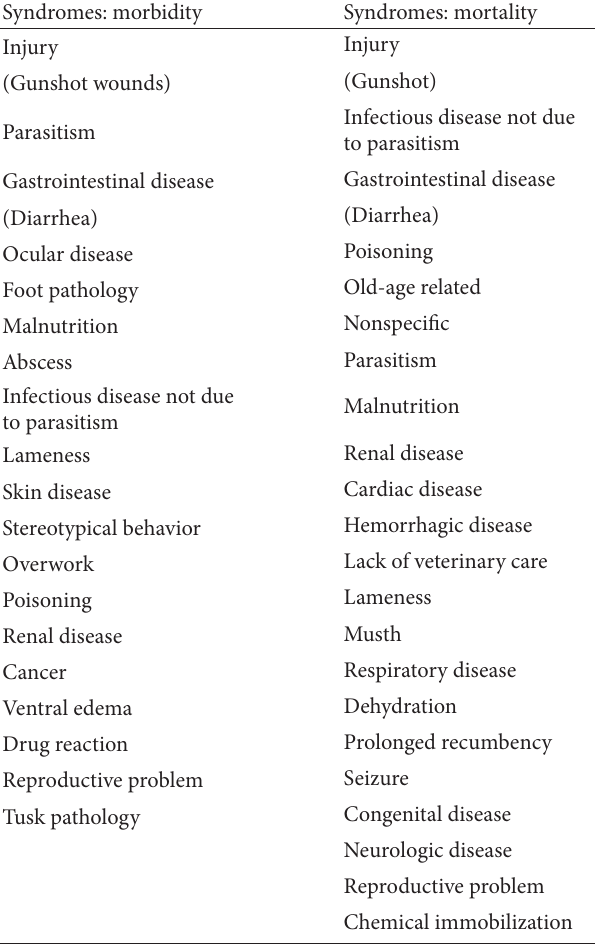
Table 6: Major syndromes reported for morbidity and mortality in Asian elephants in range countries, listed in order of most common to least common. Items in ( ) are subcategories of the immediately preceding